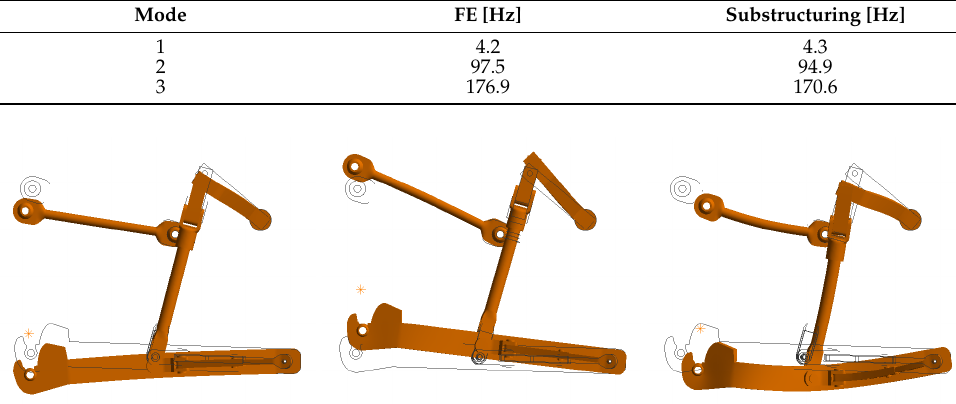
Figure 10. From left to right, mode shapes of the modes 1, 2 and 3 of the assembled system in the configuration with α 3 = 140 ◦ , computed using a FE commercial